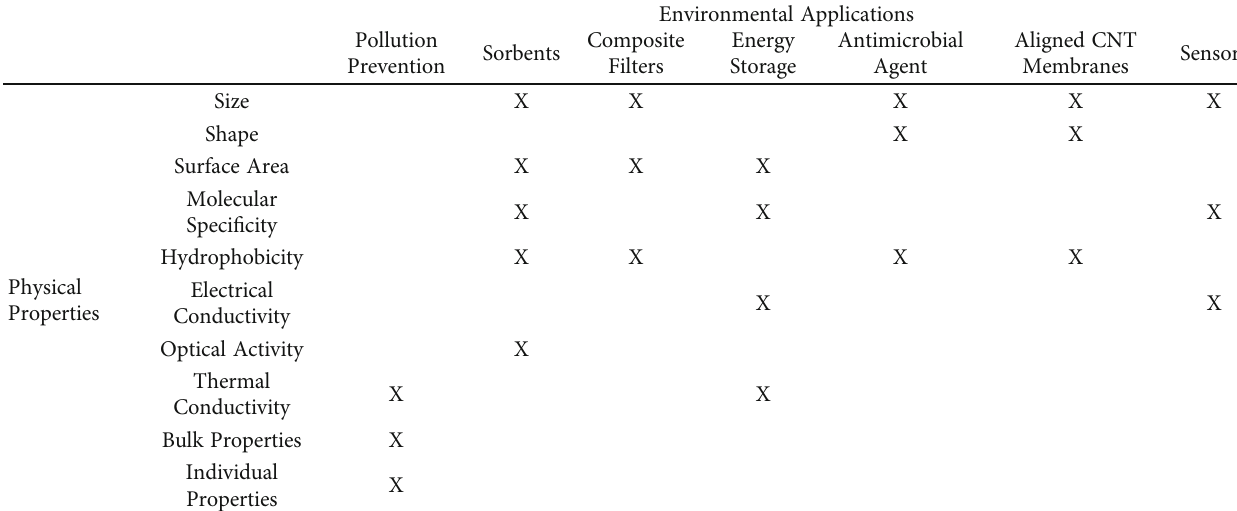
Table 1: Unique features of carbonaceous nanoparticles are applied in environmental systems. Carbonaceous nanomaterials, in both their individual and bulk forms, exhibit distinctive characteristics. The spectrum of environmental applications for carbon-based nanomaterials will be expanded through further characterization of their properties, production methodologies, and puri fi cation